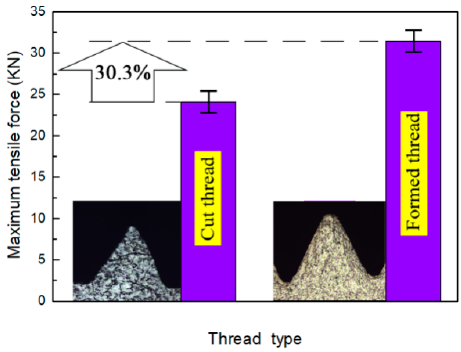
Figure 13. Comparison of the maximum tensile force of the thread with different processing methods.